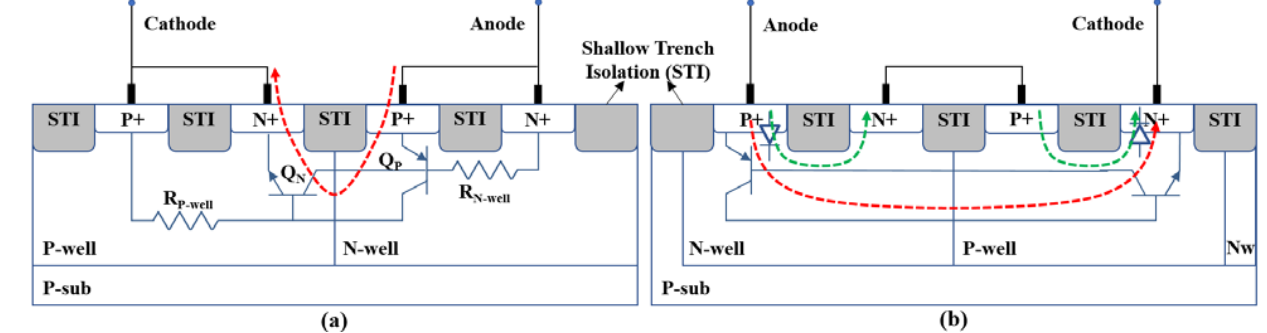
Figure 1. Cross-sectional views of SCR structures: ( a ) conventional SCR device;( b ) SCR-D proposed in this work. Color lines indicate the current flow when it is turned on.